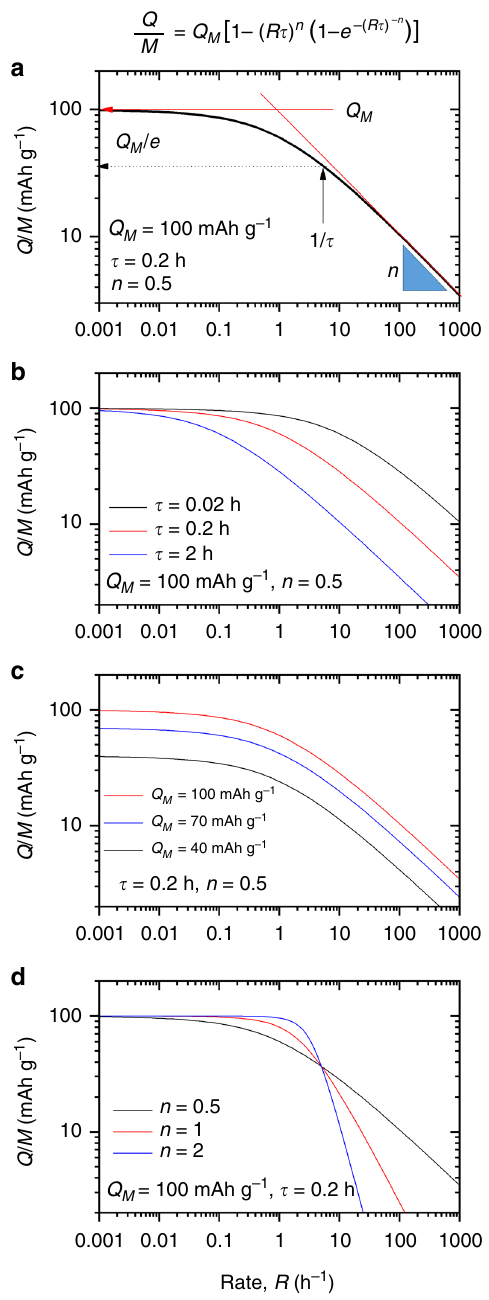
Fig. 1 Understanding the effect of the parameters de fi ning the model. a Speci fi c capacity plotted versus rate using Eq. (2) (also given above panel a ) using the parameters given in the panel. The physical signi fi cance of each parameter is indicated: Q M represents the low-rate limit of Q / M , n is the exponent describing the fall-off of Q / M at high rate and τ is the characteristic time. The inverse of τ represents the rate at which Q/M has fallen by 1/e compared to its low-rate value. b – d Plotting Eq. (2) while separately varying τ ( b ), Q M ( c ) and n ( d